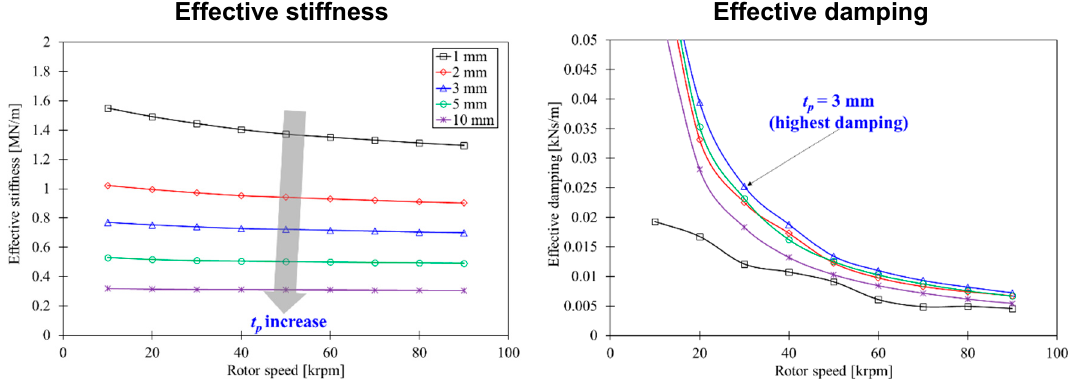
Figure 12. Predicted effective stiffness and damping versus the rotor speed depending on the polymer layer thickness.